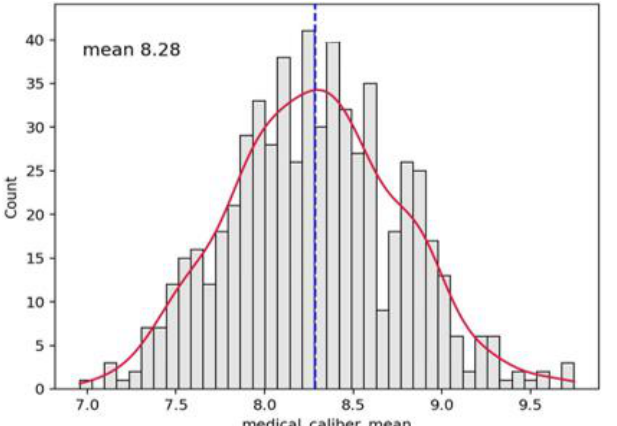
Figure 6. Histogram distribution of loop diameter for the whole video. The dashed line indicates the mean value equal to 8.28 in this case.